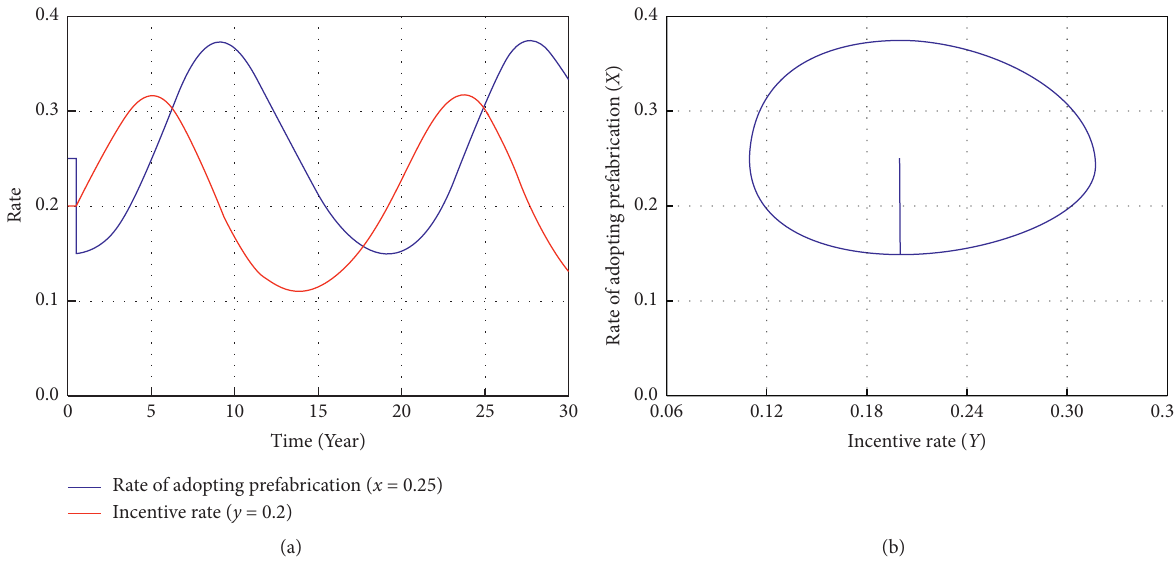
Figure 3: Simulation results when x changes from 0.25 to 0.15 at time � 5. (a) Simulation results after changing the initial strategy. (b) Trace of the systematic evolution strategy.